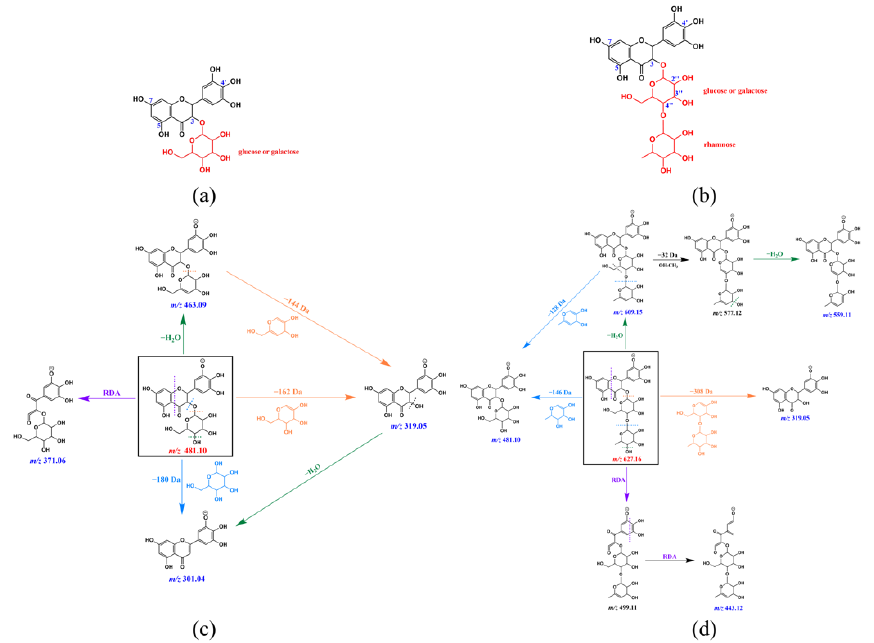
Figure 13. Possible structure and MS/MS fragmentation pathway of novel CP compounds 8 ( a , c ) and 9 ( b , d ). The site of deprotonation in [M–H] − was randomly selected, and RDA is short for Retro-Diels-Alder fragmentation. The precursor or parent ions are present in the box, and the dotted lines with different color represent different ways of fragmentation. The position of the rhamnosyl group of the compound 9 in ( b ) and ( d ) was randomly selected among C 2 ″ , C 3 ″ and C 4 ″ .